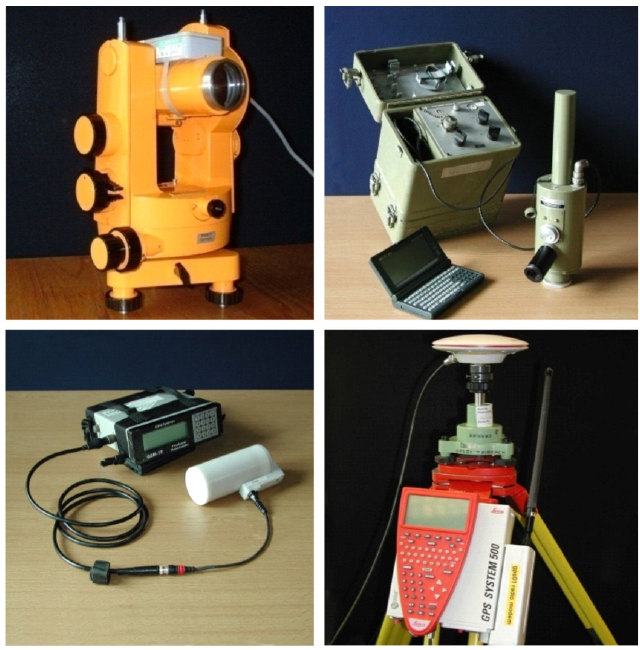
Figure 3. Survey instrumentation (clockwise: fluxgate-theodolite, gyro- scope, GPS and PPM).